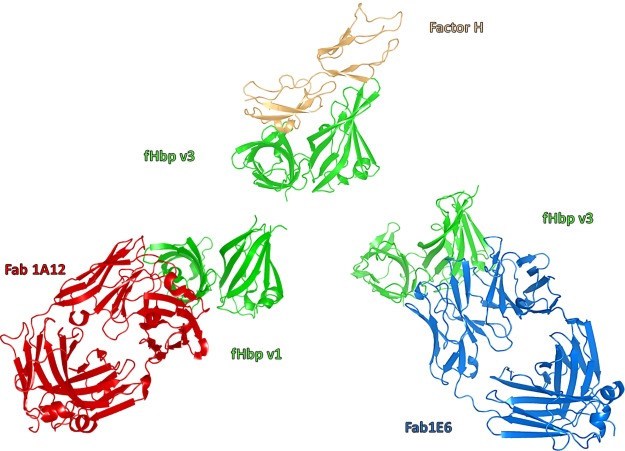
Cartoon representations of fHbp (green), bound to Fab 1A12 (red), Fab 1E6 (blue), and hfH (orange). fHbp is shown in the same orientation in all panels.